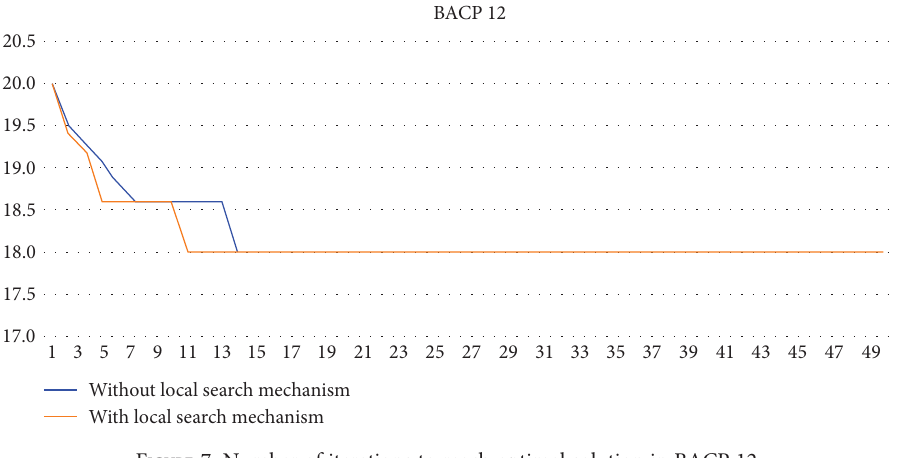
F IGURE 7: Number of iterations to reach optimal solution in BACP 12.